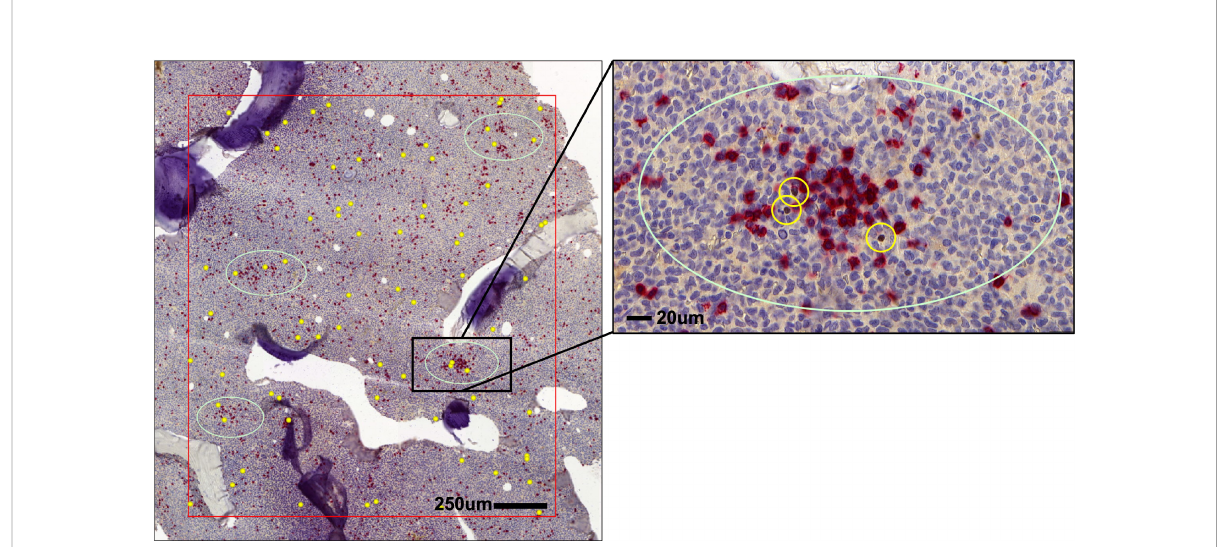
FIGURE 2 Distribution of Tregs and CD8 + T cells in AML bone marrow (BM). Spatial localization of FOXP3 + Tregs (brown, yellow circles) in respect to CD8 + T cells (red) in the BM of AML